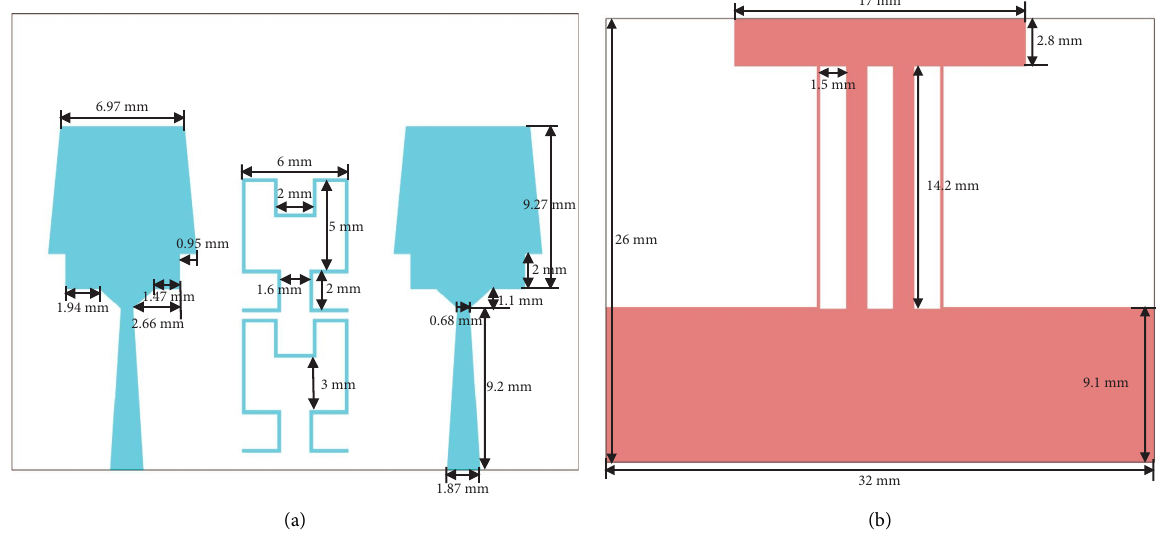
Figure 4: SWB-MIMO antenna structure. (a) Front. (b) Back.